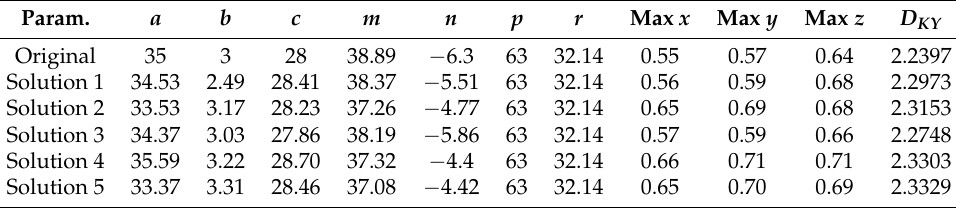
Table 3. The scaling parameters m , n , p , and r introduced by (7) provide maximum amplitudes of x , y , and z within ± 0.71, while maintaining the values of the associated D KY .